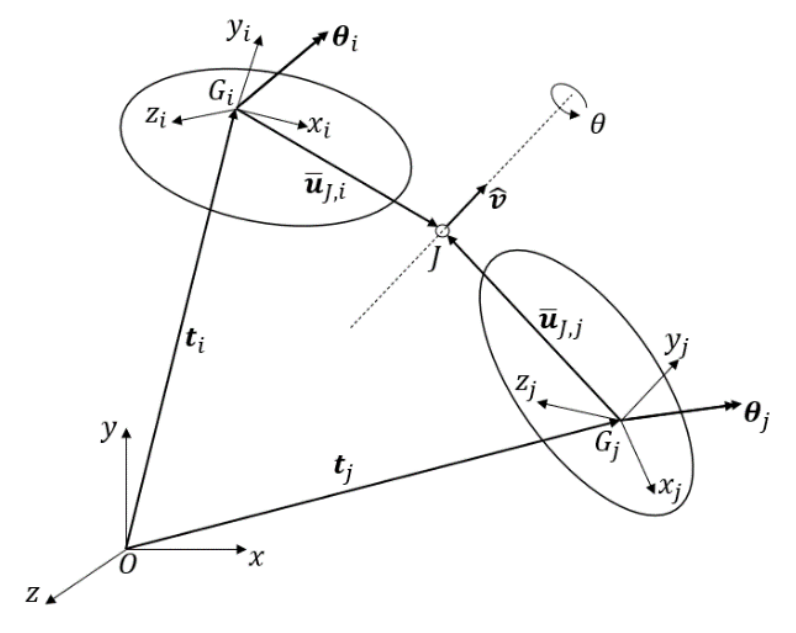
Figure 2. Revolute joint scheme.